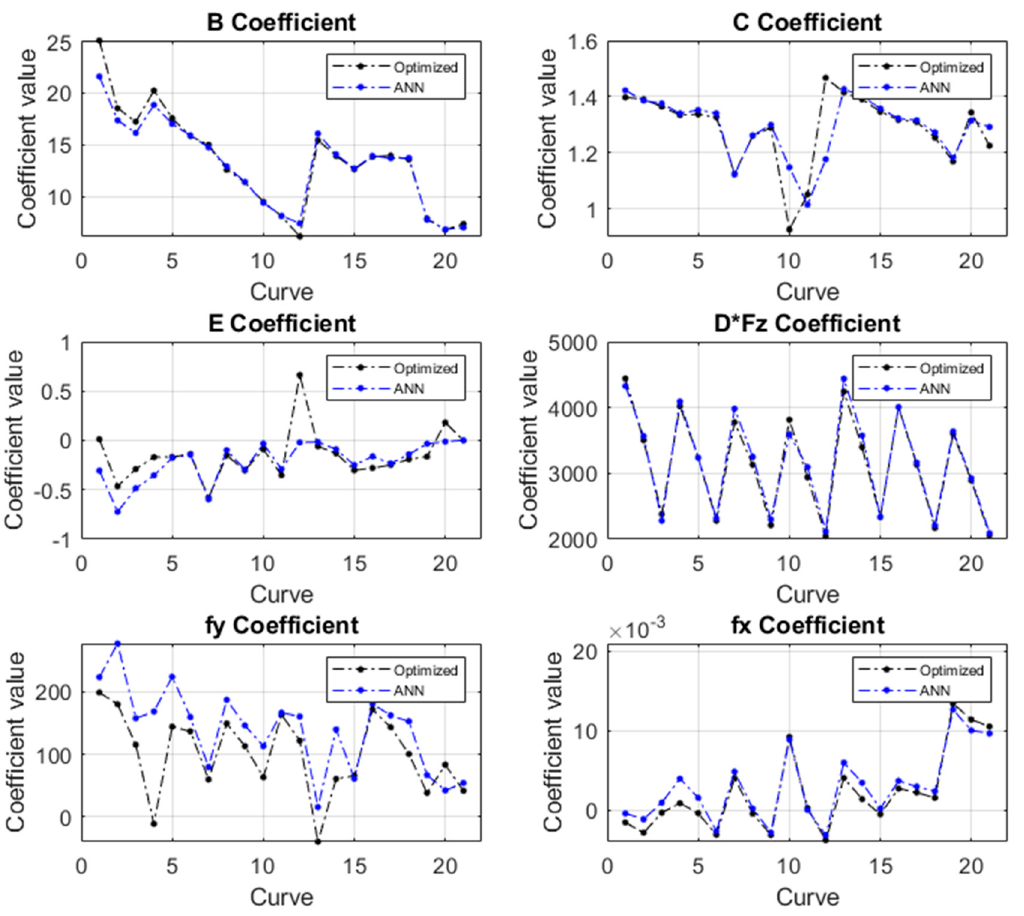
Figure 13. Comparison of real bench data point vs predicted and optimized curves. Table 3. Range of values for MF model